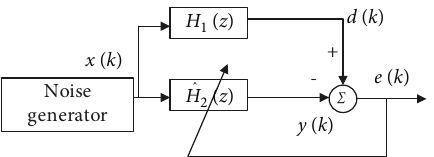
Figure 2: Schematic diagram of offline identification